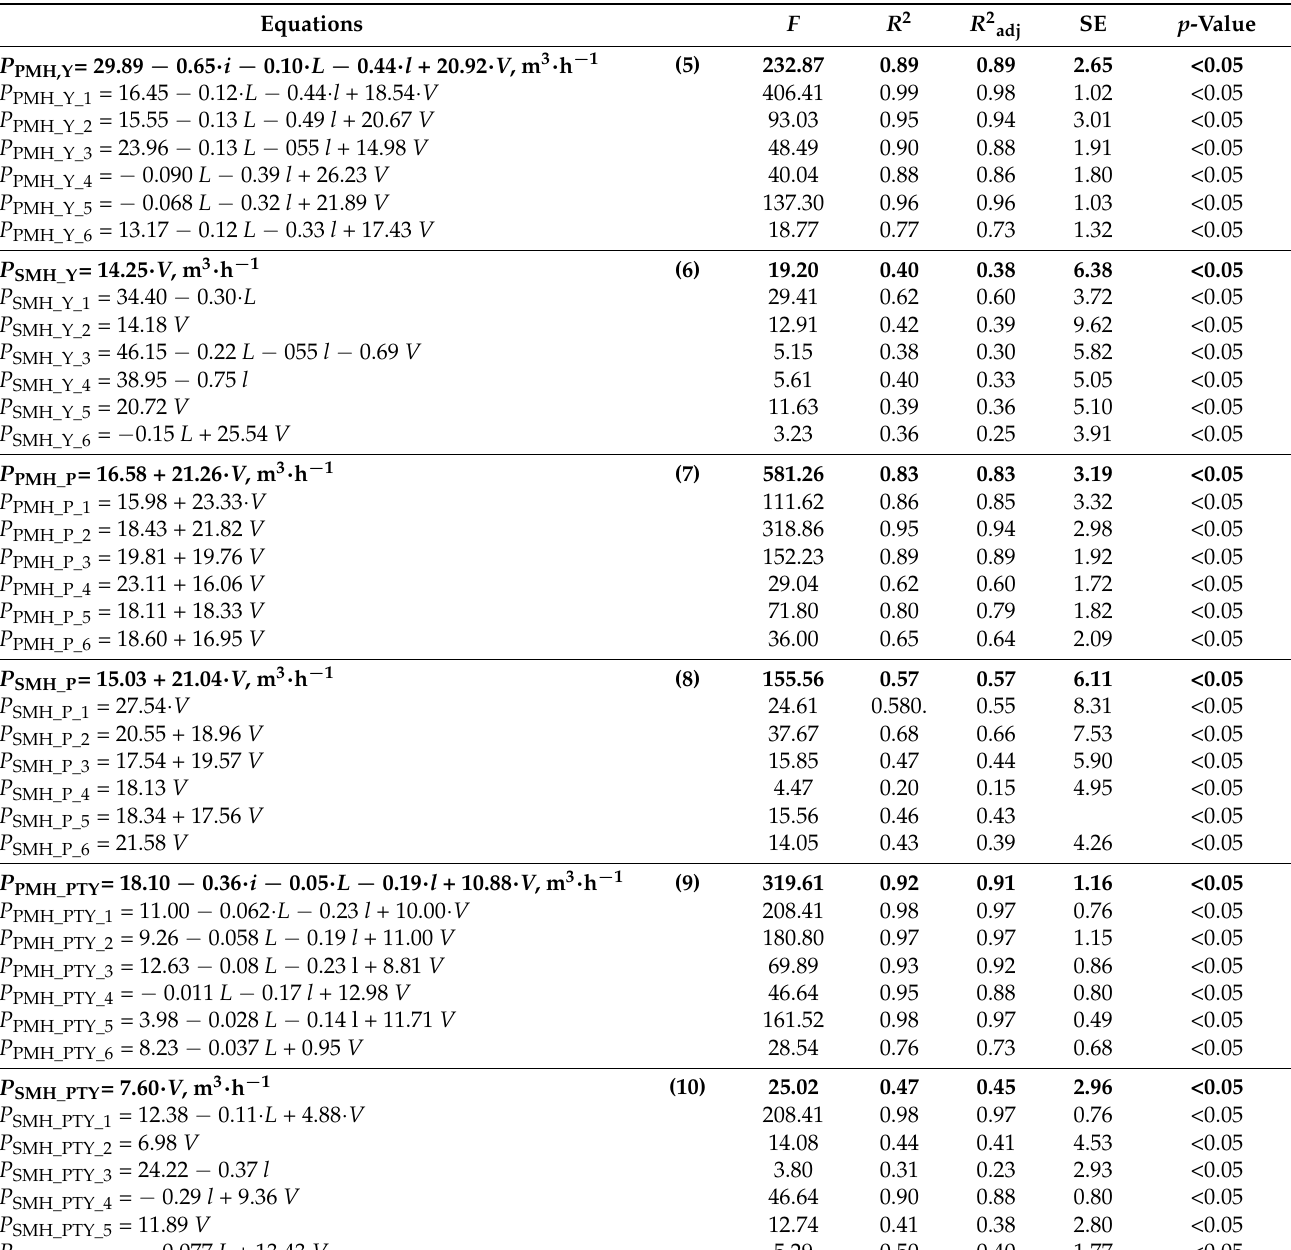
Table 5. Summary of the productivity ( P )